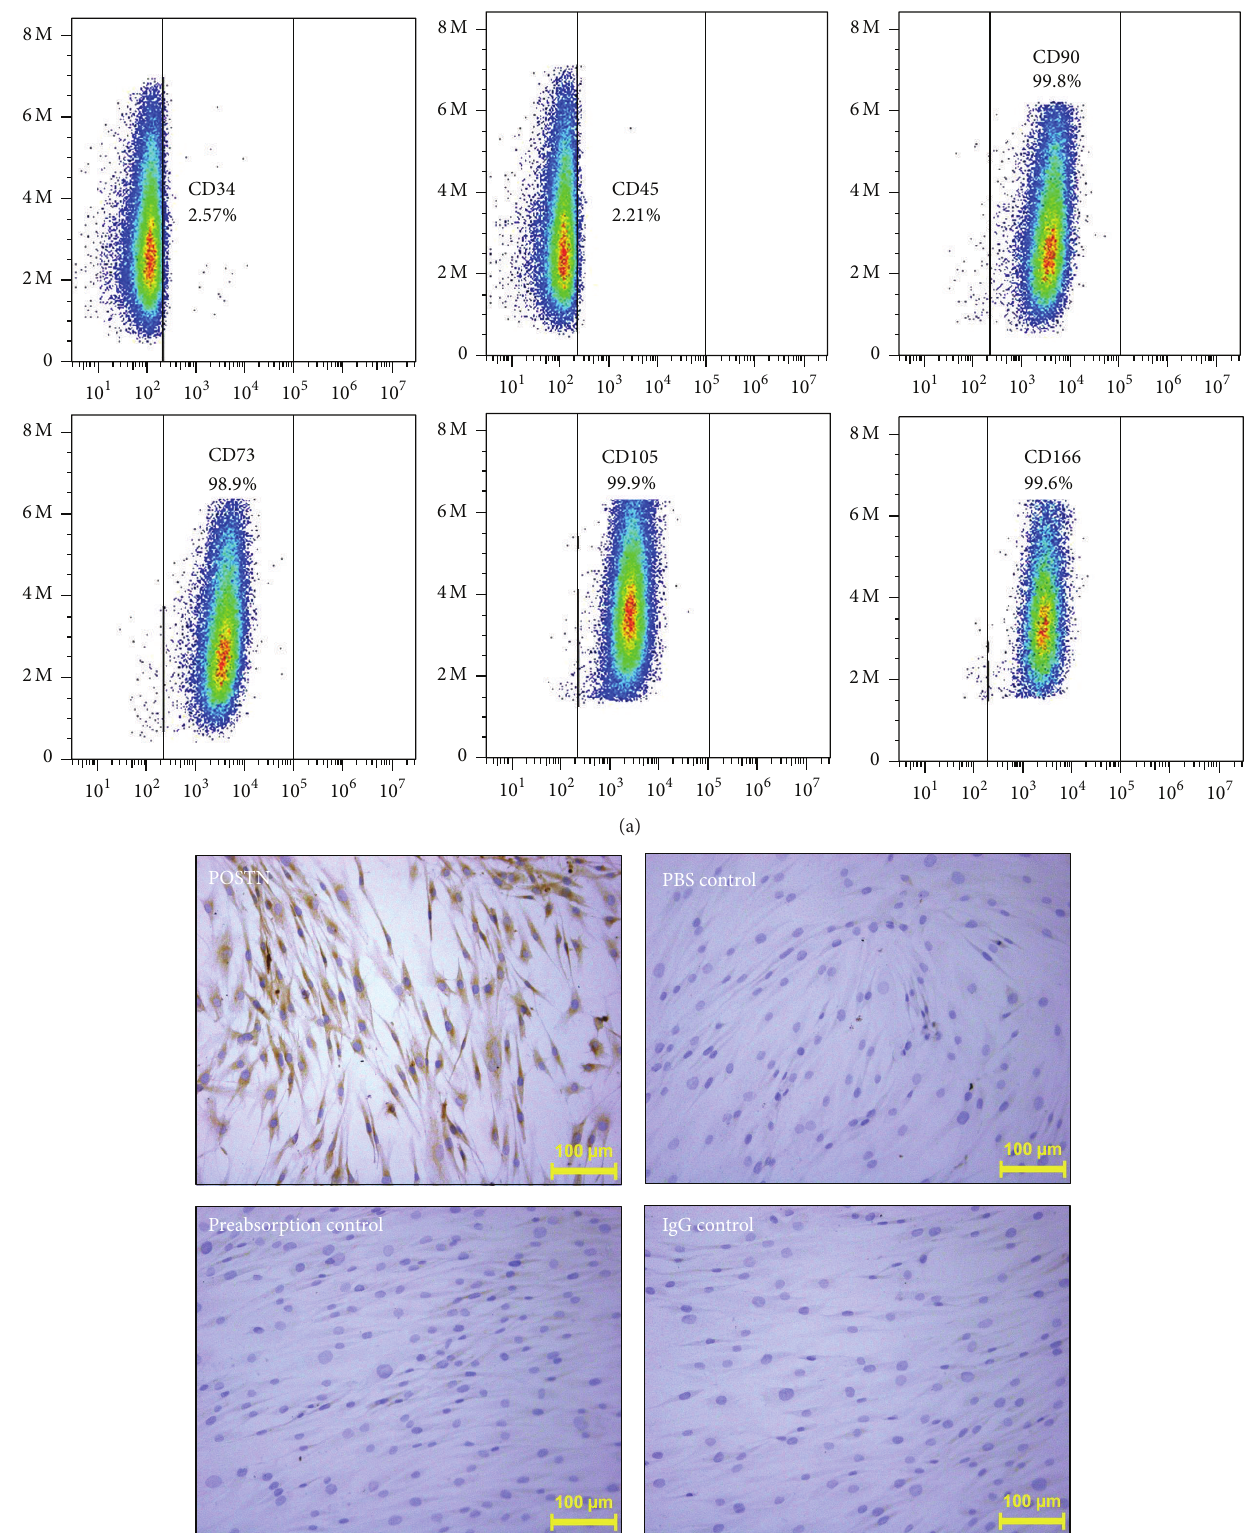
Figure 1: MSC isolation and evaluation of POSTN expression. (a) The purity of MSCs was verified by FACS according to positive staining for CD73, CD90, CD105, and CD166 and negative staining for CD34 and CD45. (b) The level and localization of POSTN expression within MSCs were detected by immunohistochemistry (magnification, ×